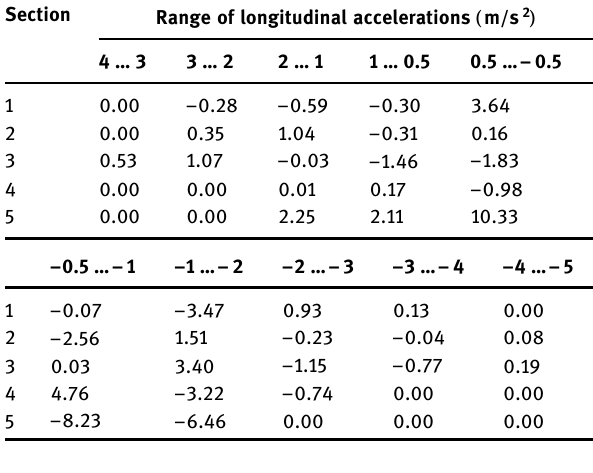
Table 5: Percentage di ff erences in the frequency of individual longitudinal accelerations Section